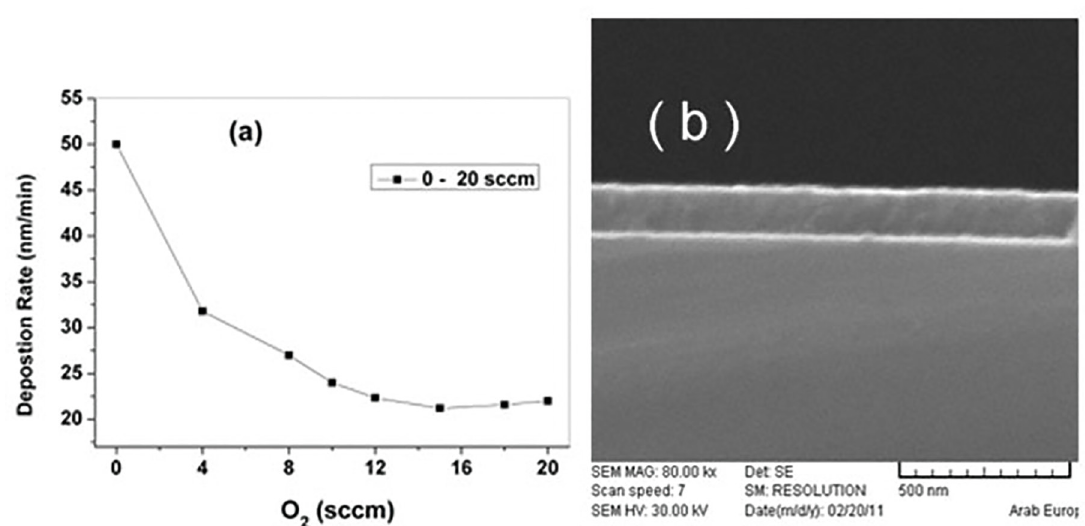
Figure 1: (a) deposition rate as a function oxygen flow and (b) SEM cross section for ZnO films deposited on Si